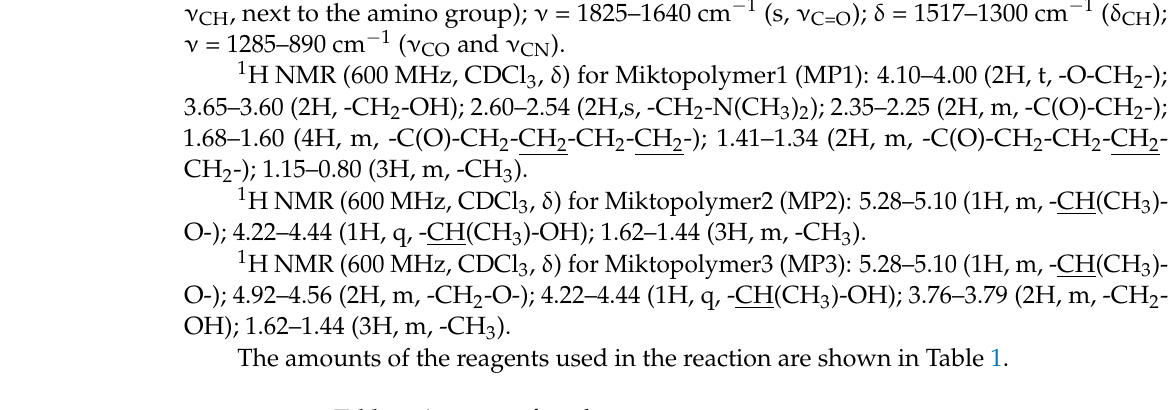
Table 1. Amounts of used